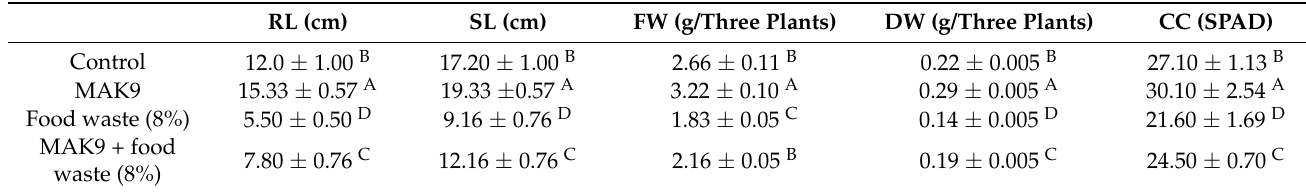
Table 1. Effect of Bacillus pumilus MAK9 on the growth attributes of Chinese cabbage.